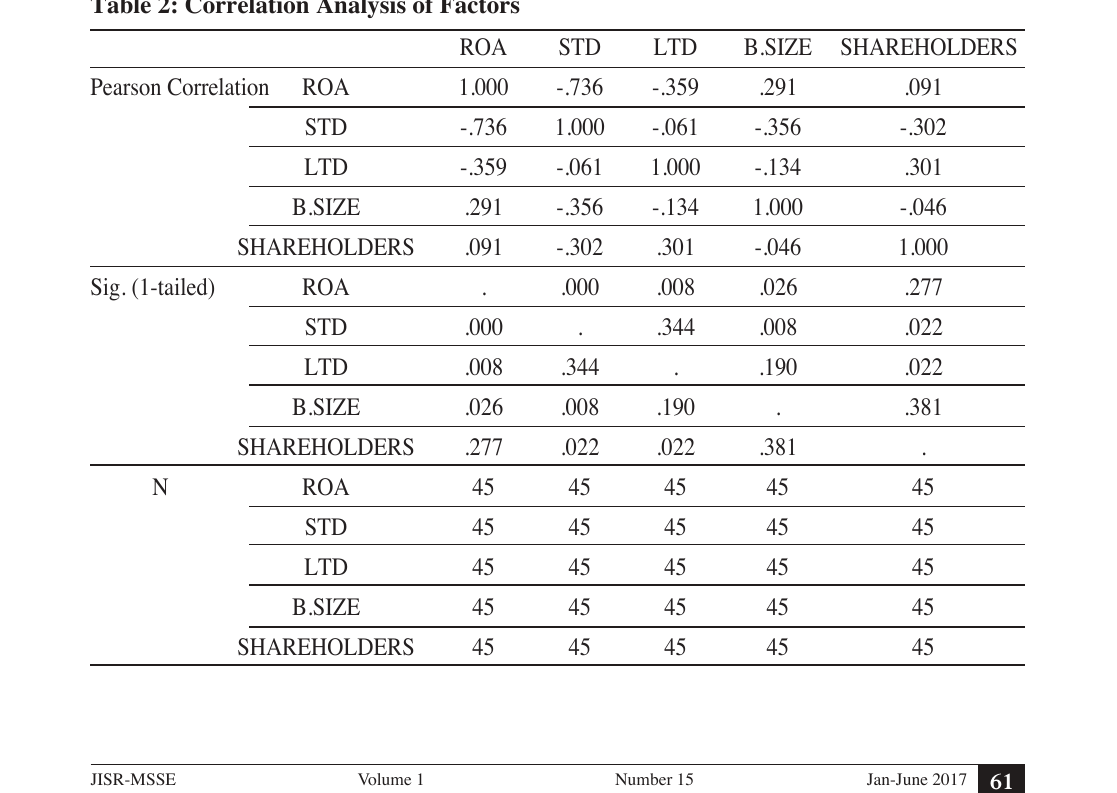
Table 2: Correlation Analysis of